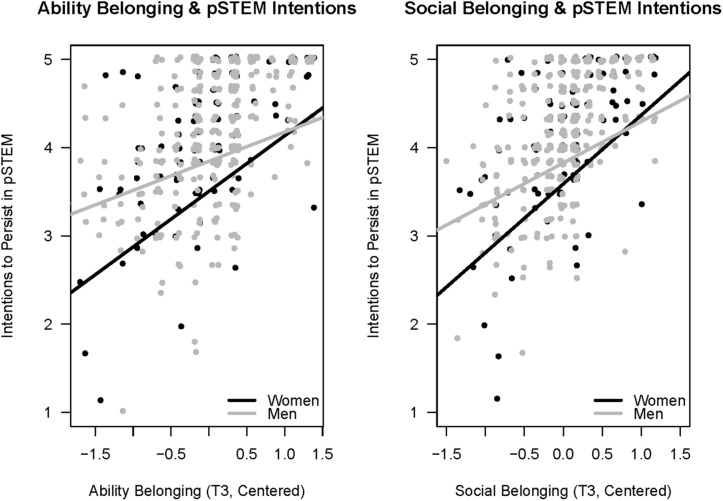
Intentions to persist as a function of belonging (ability on the left, social on the right), by gender. Lines depict partial relationships after controlling for professor, academic year, prior and ongoing performance, baseline belonging, as well as self-efficacy and identification at Time 1 and 3. Although the relationships are significant for both men and women, they are significantly stronger for women in the case of ability belonging.